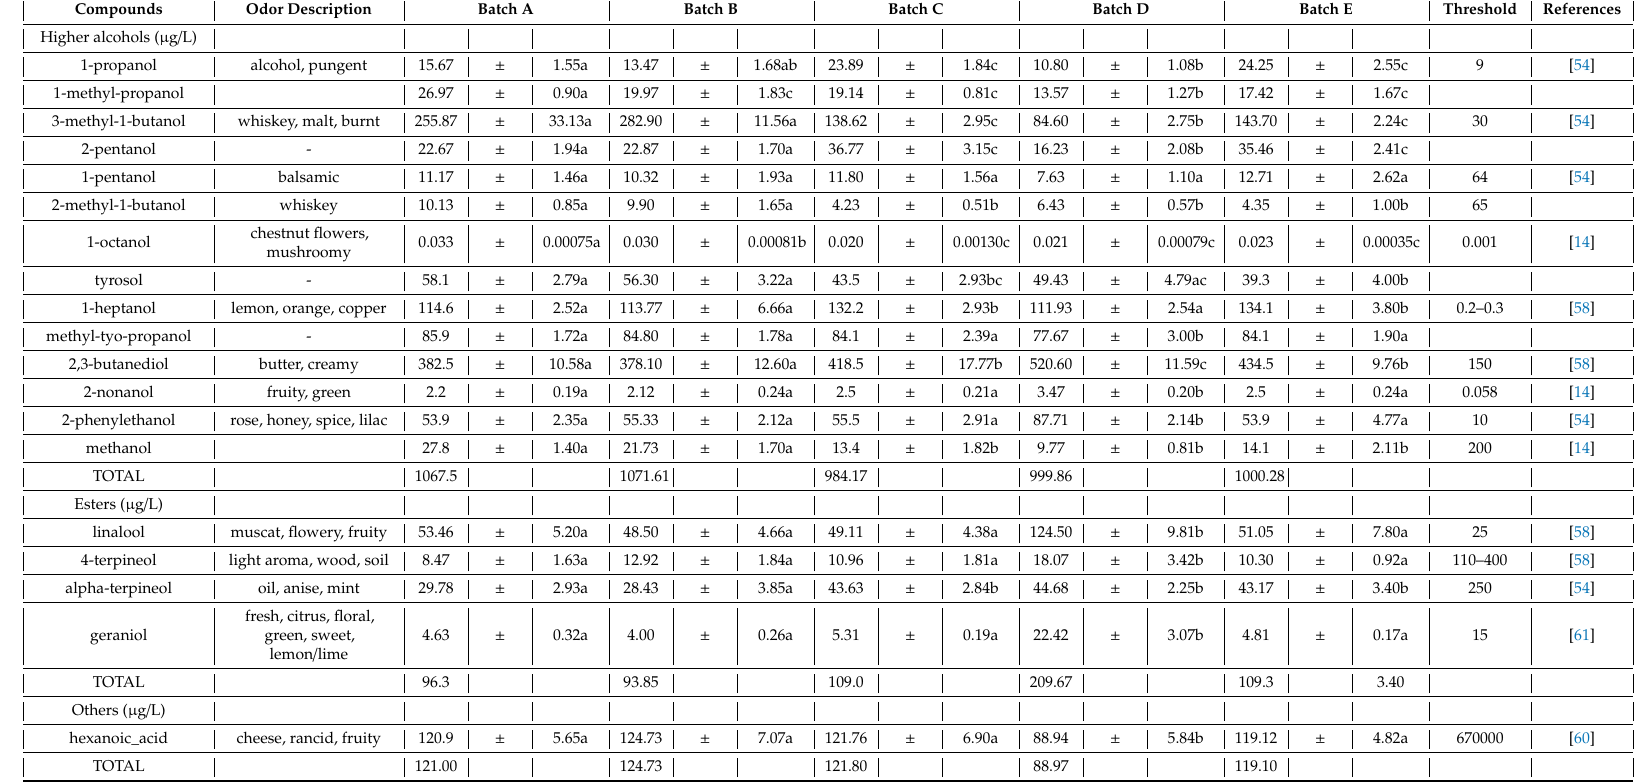
Table 2. Concentration of volatile compounds at the end of winemaking process of Fiano wines produced by di ff erent inoculum strategies. Compounds Odor Description Higher alcohols ( µ g / L) 1-propanol